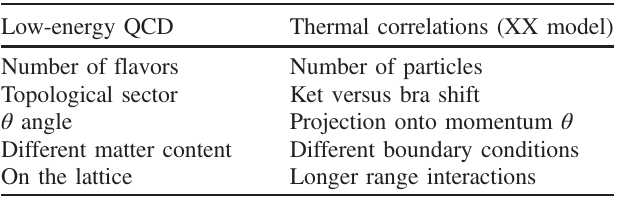
TABLE I. Dictionary relating properties of QCD with properties of the thermal averages in the XX spin